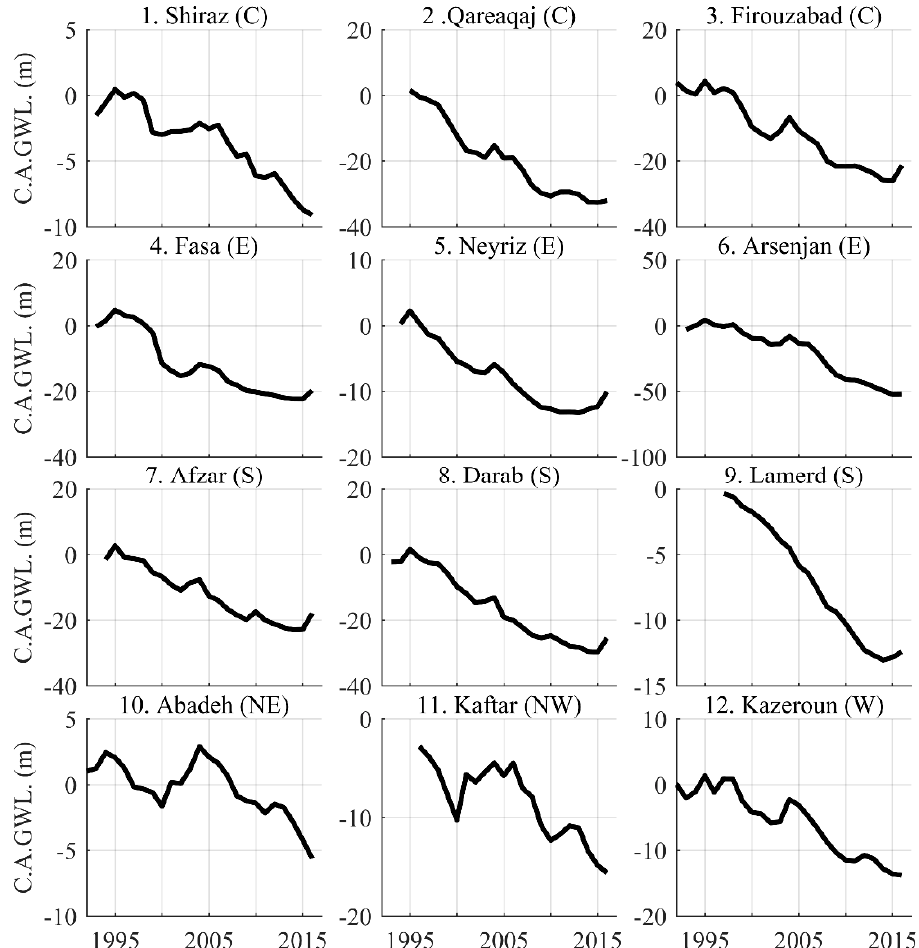
Figure 8. Cumulative average groundwater level (C.A.GWL) fluctuations in 12 aquifers in di ff erent regions of Fars province, 1995–2016. Regions: W: western, NW: northwestern, C: central, S: southern, E: eastern, and NE: